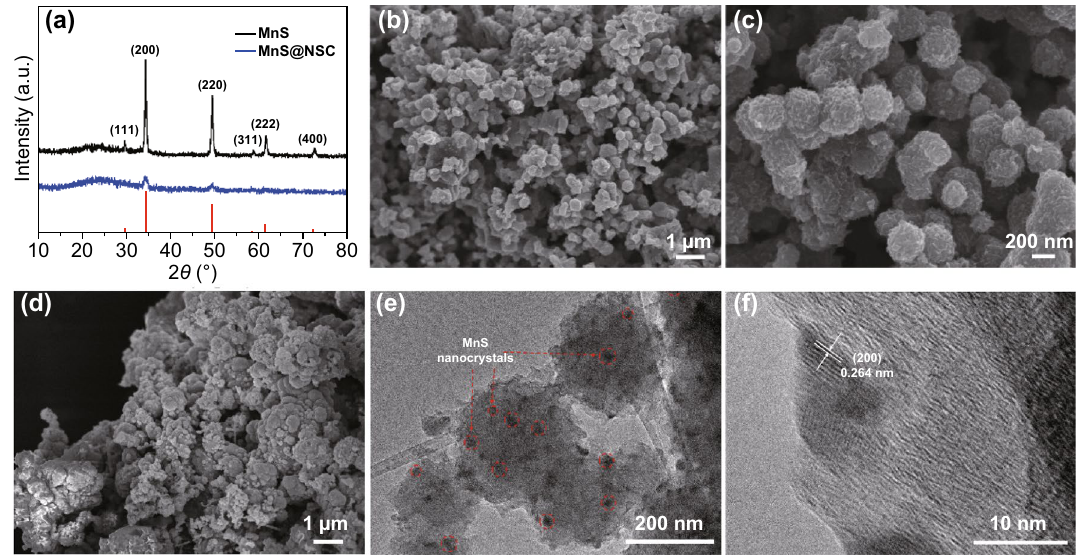
Fig. 1 a XRD patterns of MnS and MnS@NSC. b , c SEM images of MnS@NSC. d SEM image of MnS. e TEM and f HRTEM images of MnS@NSC